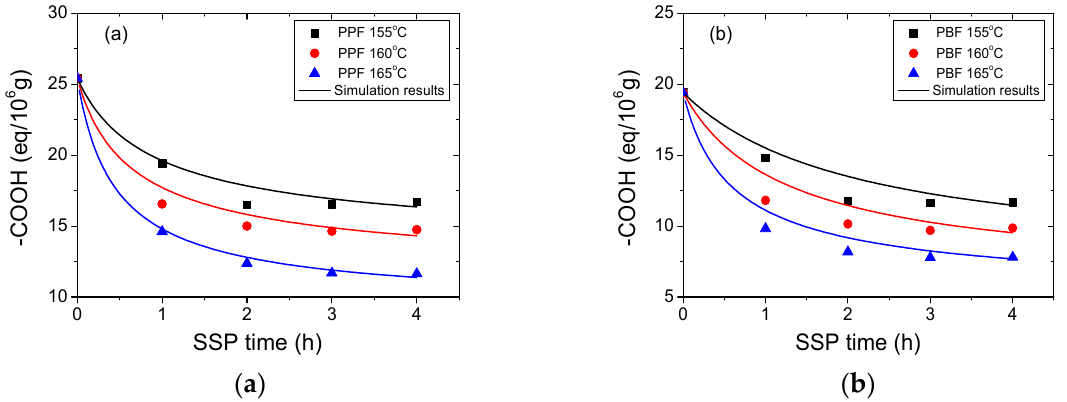
Figure 4. Evolution of carboxyl (–COOH) end-groups concentration with time during SSP of ( a ) PPF and ( b ) PBF polyesters at different temperatures. The theoretical data obtained by the kinetic model simulation are represent by the continuous lines.